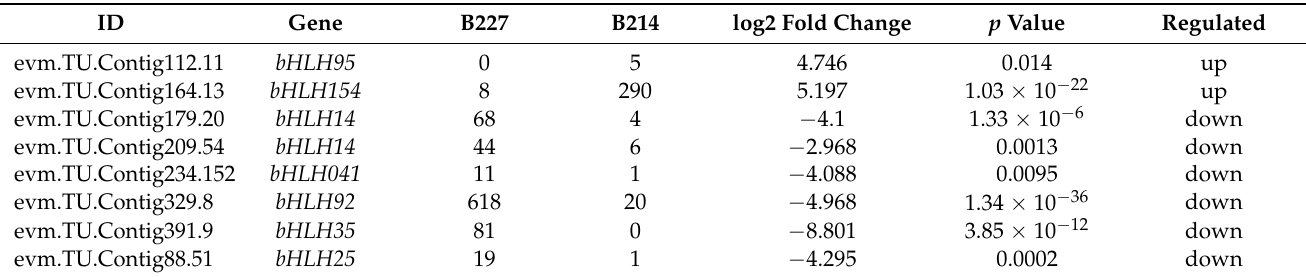
Table 4. Differentially expressed bHLHs in the mature pericarp of B214 and B227.